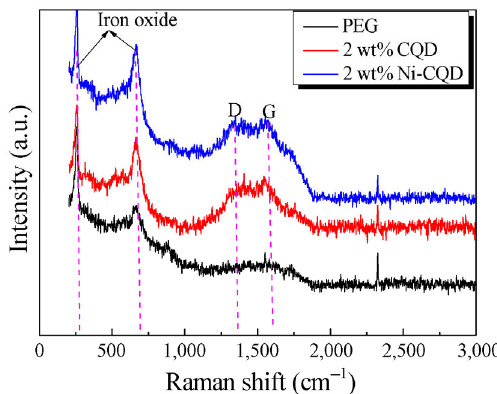
Fig. 13 Raman spectroscopy of wear zones lubricated with pure PEG200, PEG200+2 wt% CQD, and PEG200 + 2 wt% Ni-CQD particles.